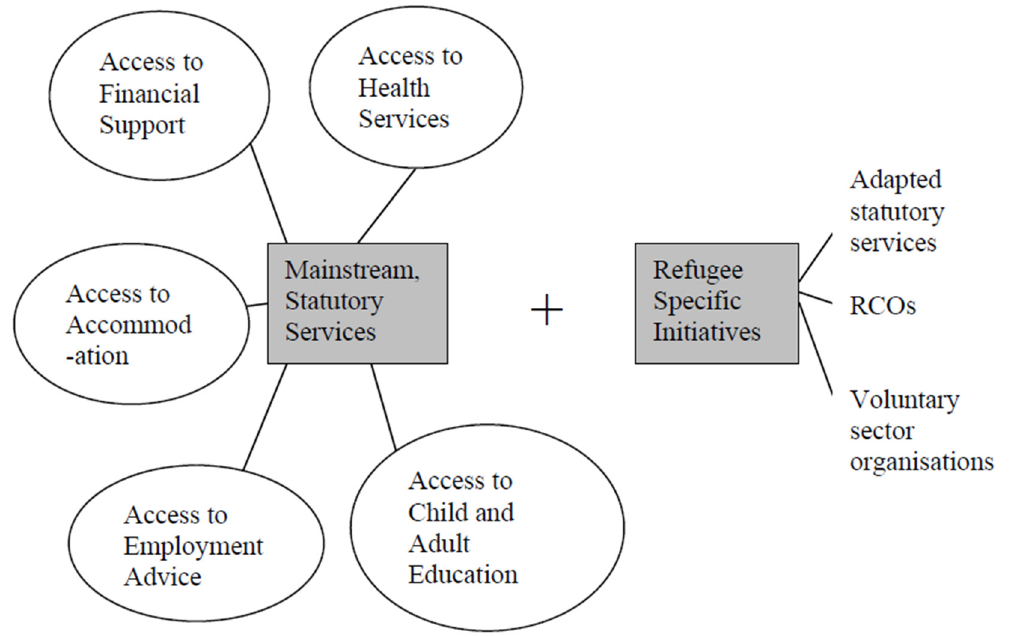
Figure 1. Past structure of provision for refugees.